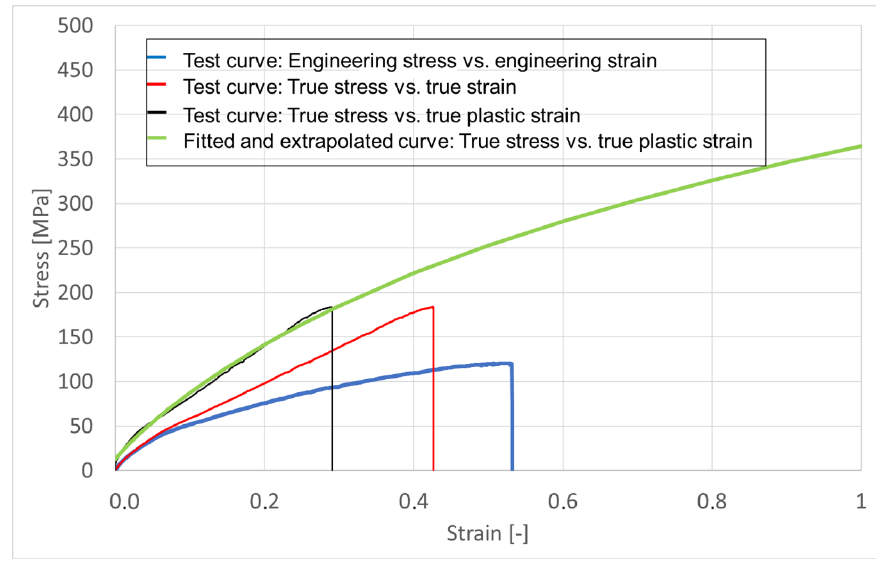
Figure 8. Steps for generating the hardening curve, obtained from the real test (blue curve) to the final hardening curve needed as an input for the FE solver (green).